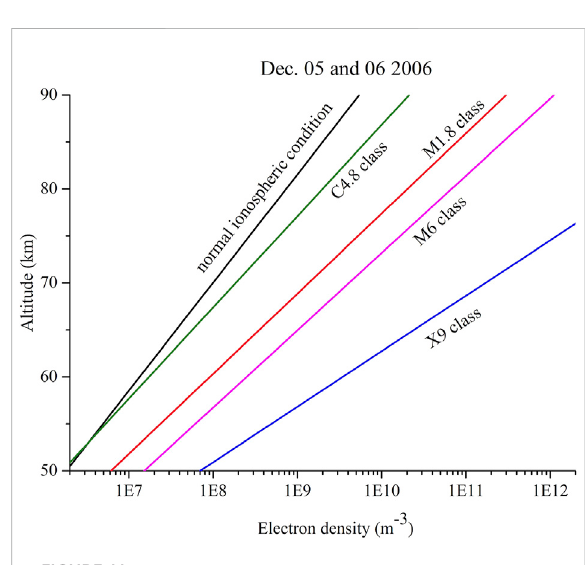
FIGURE 11 Altitude pro fi le of electron density at normal ionospheric condition (black line) and for the four solar fl are events occurred on 05 and 06 December 2006.